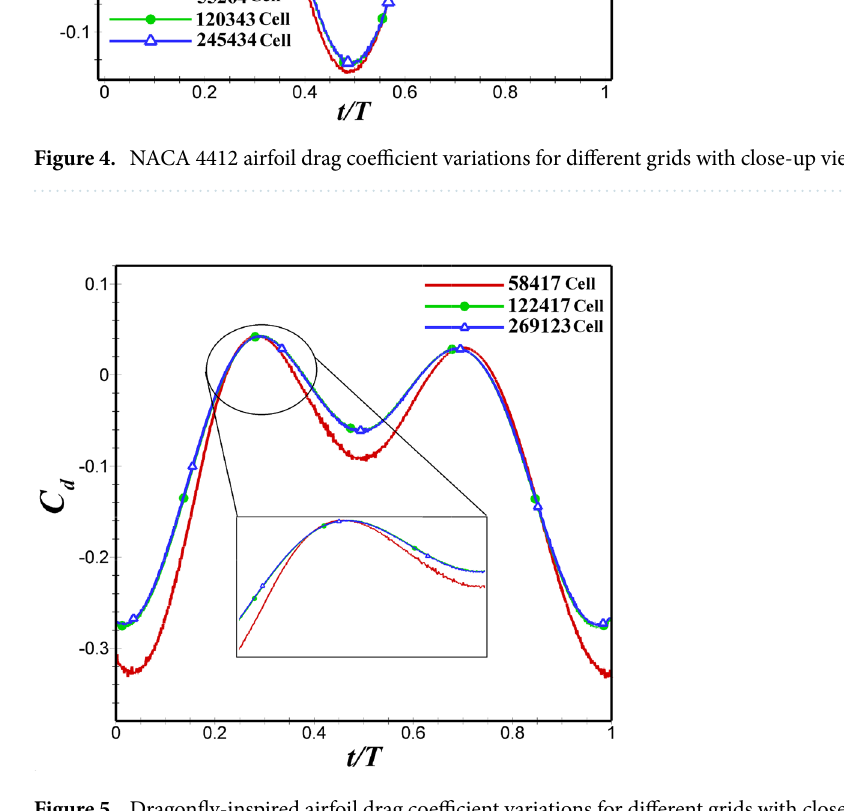
Figure 5. Dragonfly-inspired airfoil drag coefficient variations for different grids with close-up